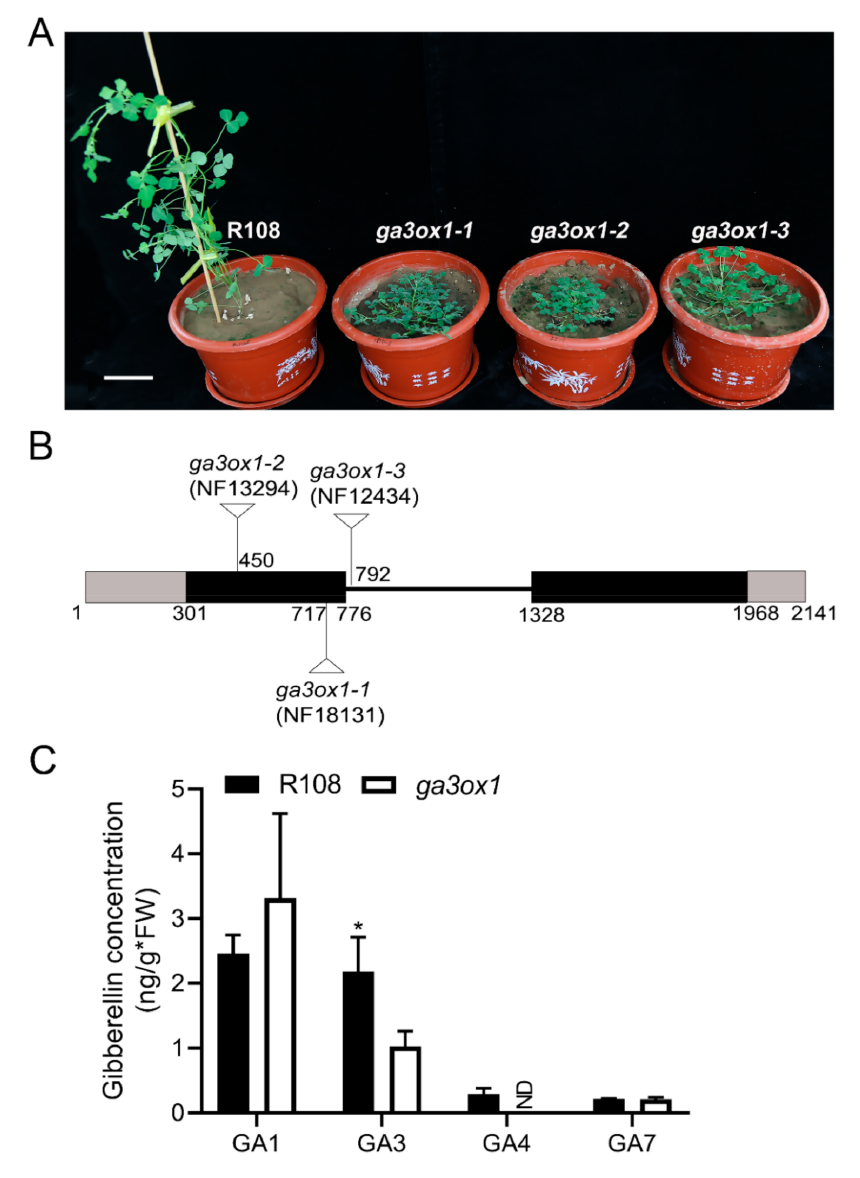
Figure 1. Screening and identification of ga3ox1 mutants. ( A ) Phenotypes of ga3ox1 null mutants. The ga3ox1 mutant displays a dwarf phenotype. Bar = 5 cm. ( B ) Position of Tnt1 insertions in the GA3ox1 gene in the mutant lines ga3ox1-1 (NF18131), ga3ox1-2 (NF13294) and ga3ox1-3 (NF12434). Gray boxes indicate the 5 (cid:48) UTR and 3 (cid:48) UTR. Dark boxes indicate exons, and the line indicates the intron. ( C ) Determination of the content of bioactive GAs content based on HPLC-MS analysis. Three biological replicates were analyzed. Error bars indicate SD. * p < 0.05 by Duncan test. NA: not